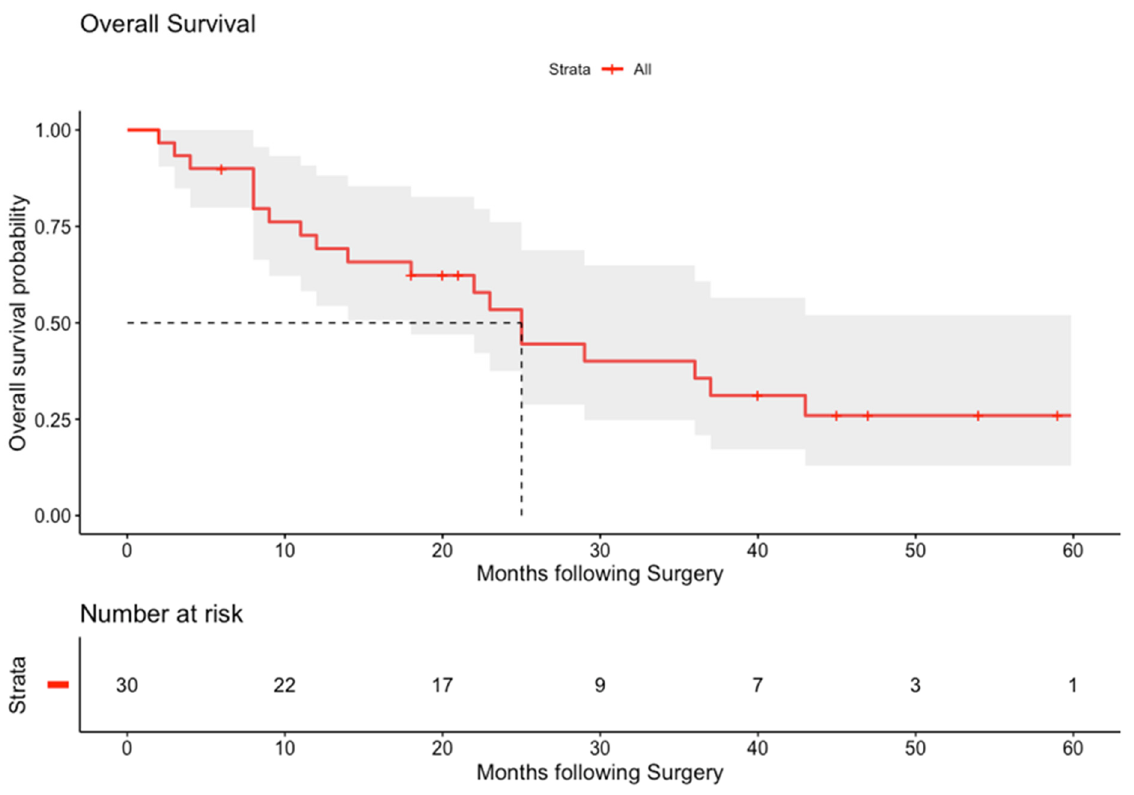
Figure 1. Kaplan–Meier curve for disease-free survival. Data show time to recurrence in months. Shaded blue area shows 95% CI. Number at risk at each timepoint provided.